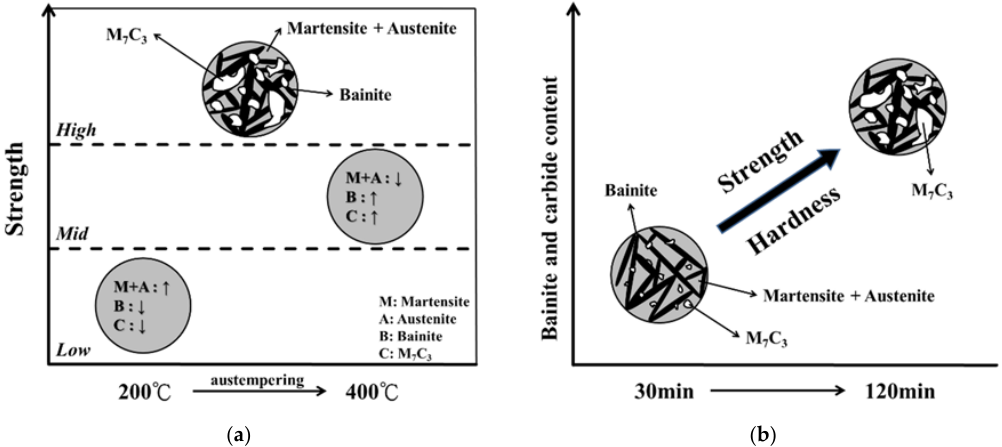
Figure 14. Diagram of tensile mechanical properties with different salt ‐ bath conditions: ( a ) different salt ‐ bath temperatures, and ( b ) different salt ‐ bath times.